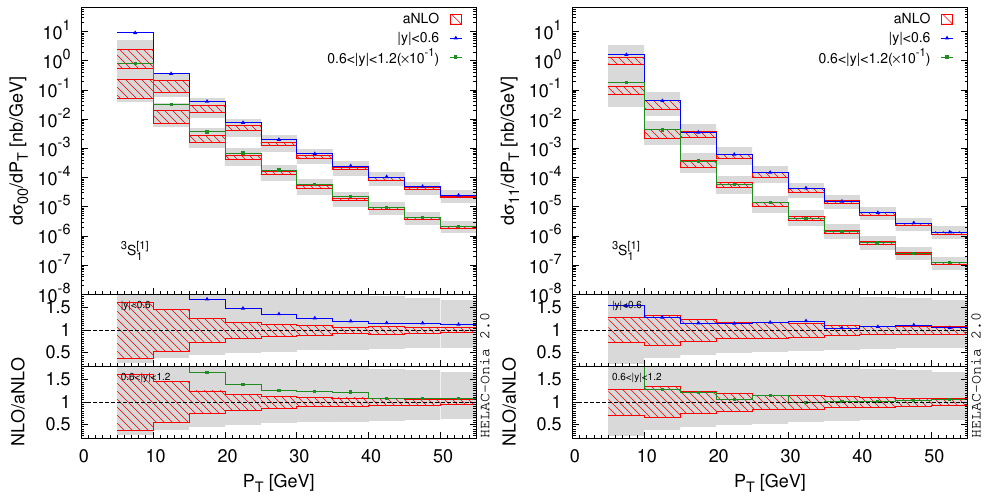
Figure 2 . Comparisons of spin-dependent differential cross sections for the Fock state 3 S [1] our aNLO calculations and the complete NLO